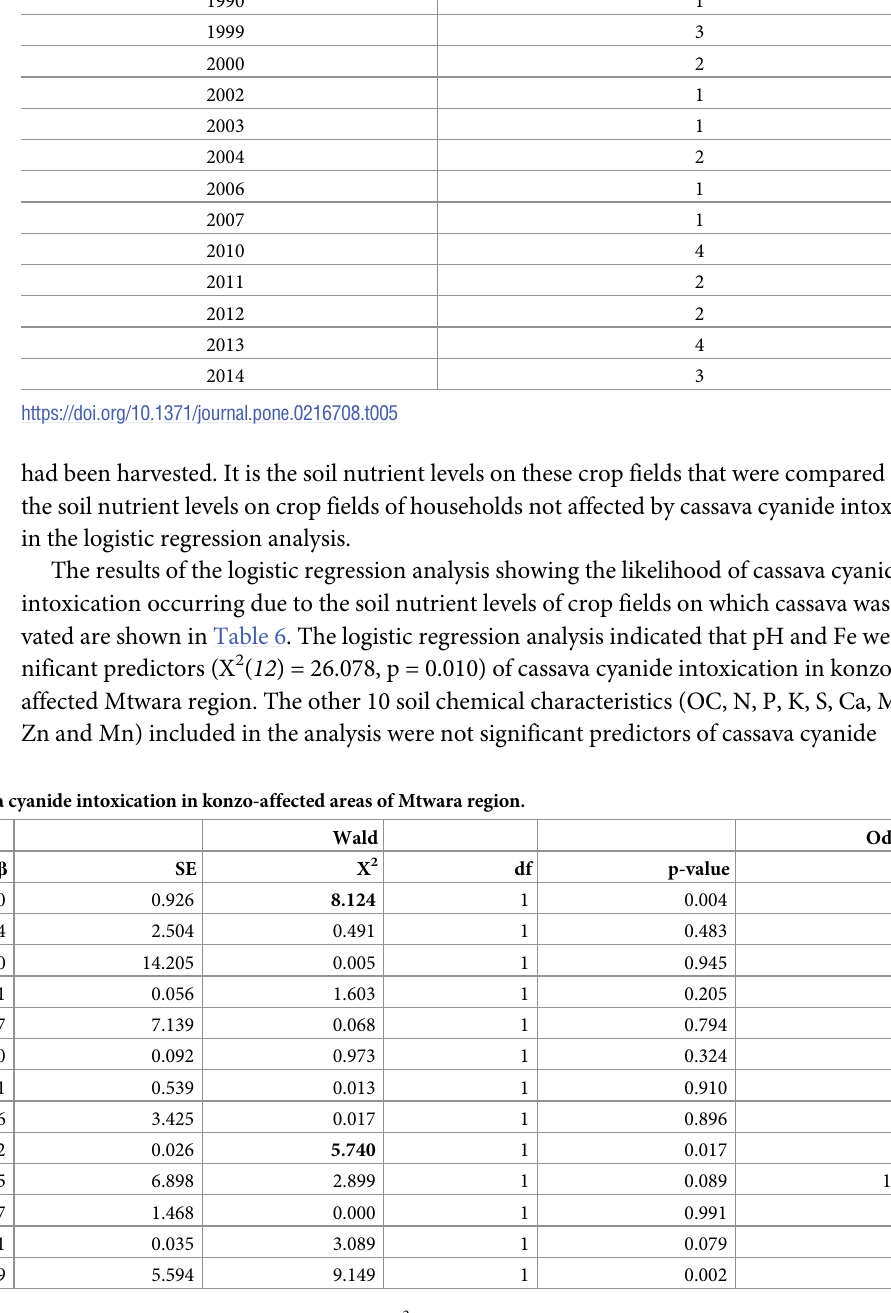
Table 5. Cassava cyanide intoxication experiences as reported by farmers in konzo-affected areas of Mtwara region.